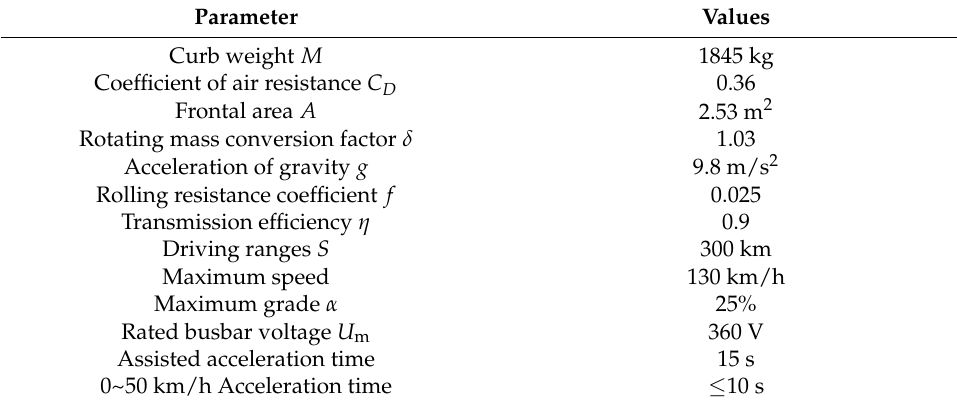
Table 1. Parameters and performance indicators of the EV.